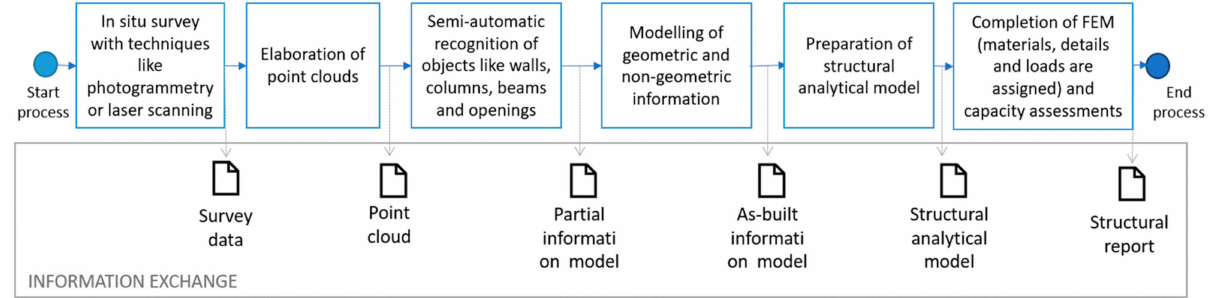
Figure 9. BIM-based workflow for BIM use